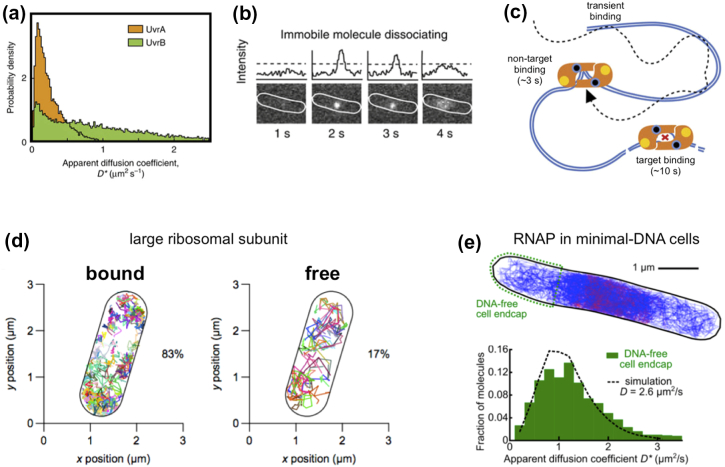
Use of tracking-PALM to characterize the diffusion, interactions and exclusion areas of proteins and their complexes. (a) The apparent diffusion coefficient of UvrA and UvrB are dramatically different, with most UvrA showing stable binding to DNA, and most UvrB showing much faster diffusion. (b) Example of the detection of a full binding event of UvrA to non-target DNA; the blurred image at 4 s indicates protein dissociation from the DNA (as opposed to photobleaching). (c) A schematic summary of the DNA-binding modes of UvrA with the DNA in the presence of bulky DNA damage. Panels a–c are adapted from Ref. [47].(d) The diffusion profile from single bacterial cells shows that free ribosomal subunit has full access to the nucleoid area (roughly highlights by the tracks on the right panel), where bound subunits are largely excluded from the nucleoid. Adapted from Ref. [48]. (e) The diffusion profile of RNA polymerase in cells with minimal DNA leaves DNA-free regions closed to the cell endcaps (top panel); diffusion from these regions shows that RNA polymerase diffuses much faster than in the presence of DNA and consistent with a corrected diffusion coefficient of 2.6 μm2/s, as opposed to 0.4 μm2/s in the presence of DNA. Adapted from Ref. [49].